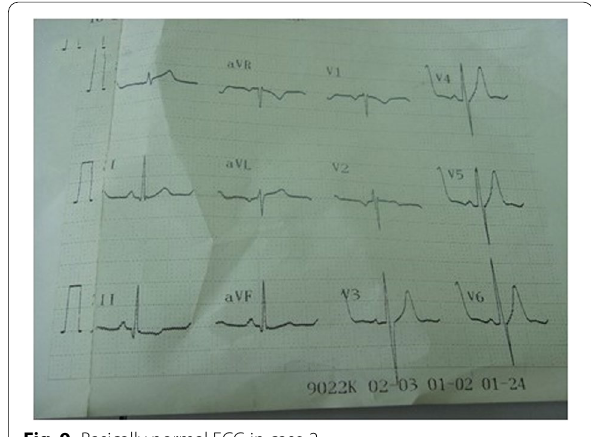
Fig. 9 Basically normal ECG in case 2